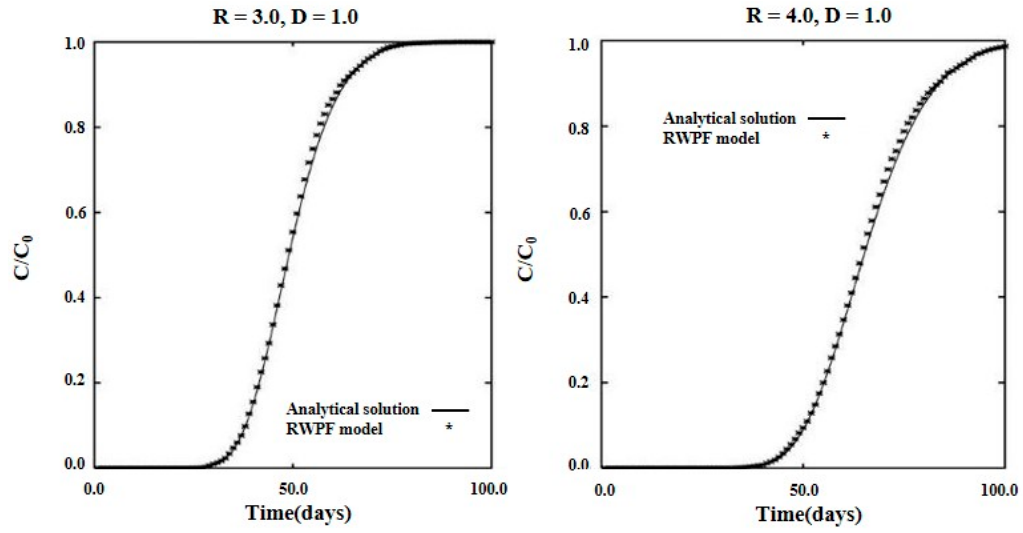
Figure 3. Comparison of simulation results of solute particle transport with R with analytical solutions: the value of D was fixed to 1.0 m 2 /sec.